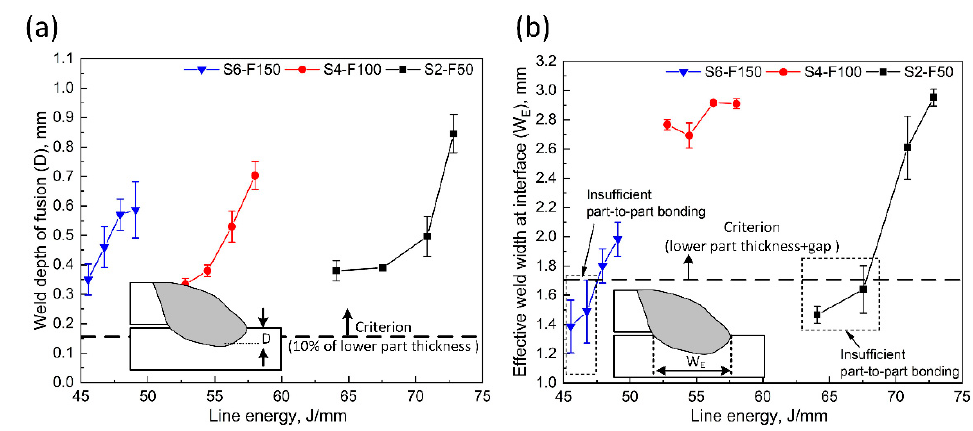
Figure 3. Evaluation of weld shape as function of welding parameters. ( a ) Weld depth of fusion and ( b ) effective weld width at interface.